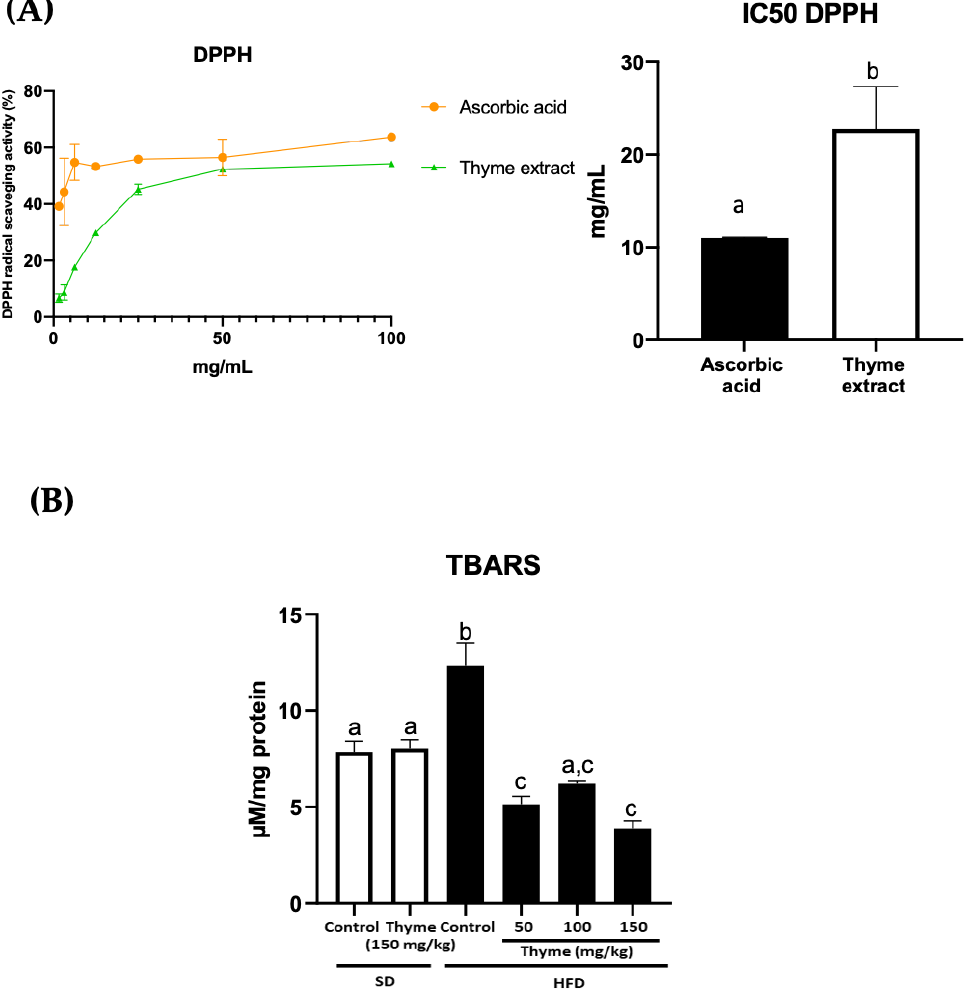
Figure 1. Antioxidant activity of Thyme extract: ( A ) DPPH activity scavenging of thyme extract, ascorbic acid and ferulic acid and their IC 50 values; ( B ) TBARS production in liver lysates. Data are expressed as means ± SEM ( n = 4). Groups with different letters statistically differ ( p < 0.05).